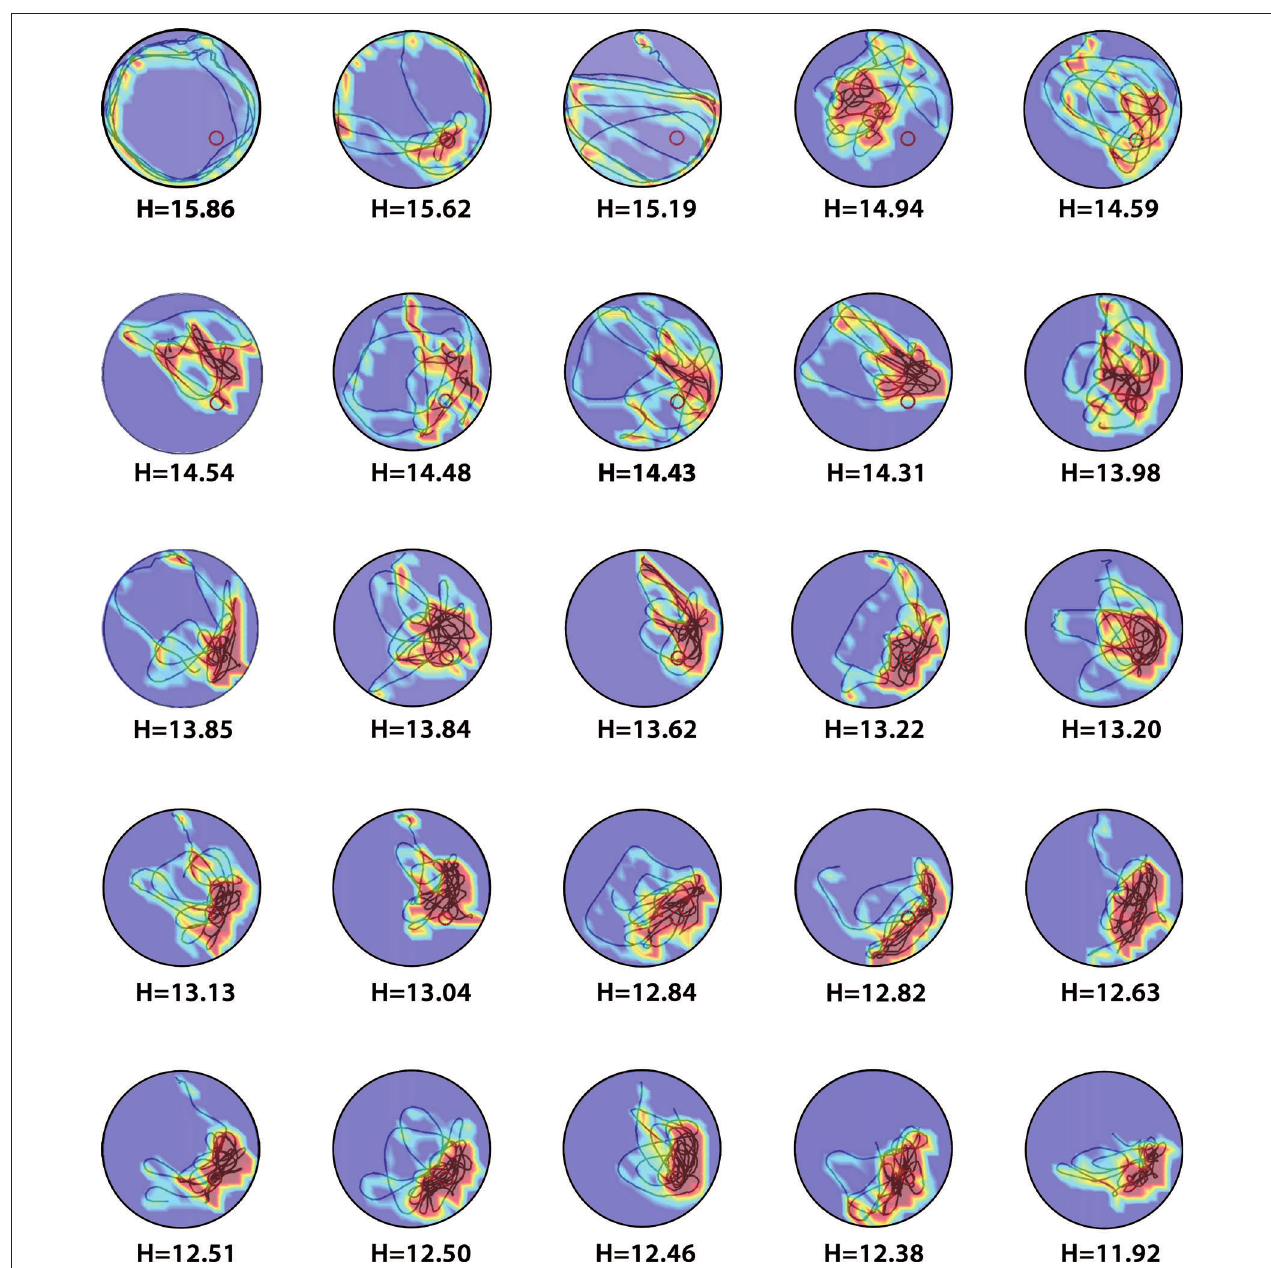
FIGURE 2 | Sample H -scores for a range of probe test performances. The density plot generated from an individual trial is overlaid on top of the animal’s trajectory during that trial, showing where the mice concentrated their